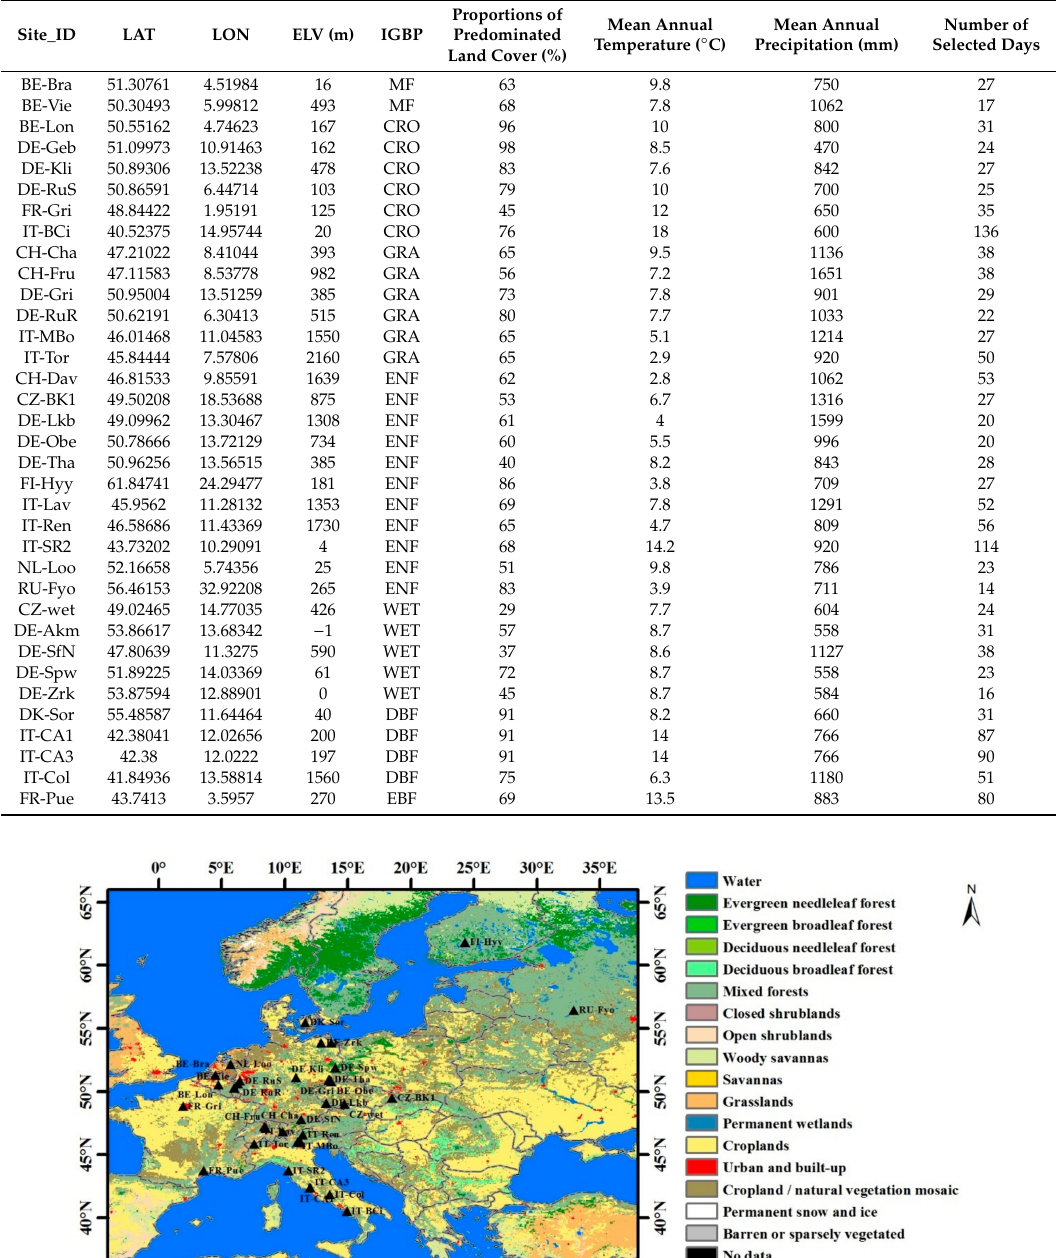
Table 1. General information of 35 sites from the FLUXNET2015 dataset. Note: LAT, latitude; LON, longitude; ELV, elevation; IGBP, International Geosphere–Biosphere Programme (here it means the classification scheme of land use and land cover from IGBP); MF, mixed forests; CRO, croplands; GRA, grasslands; ENF, evergreen needleleaf forest; WET, Permanent Wetlands; DBF, deciduous broadleaf forest; EBF, evergreen broadleaf forest.